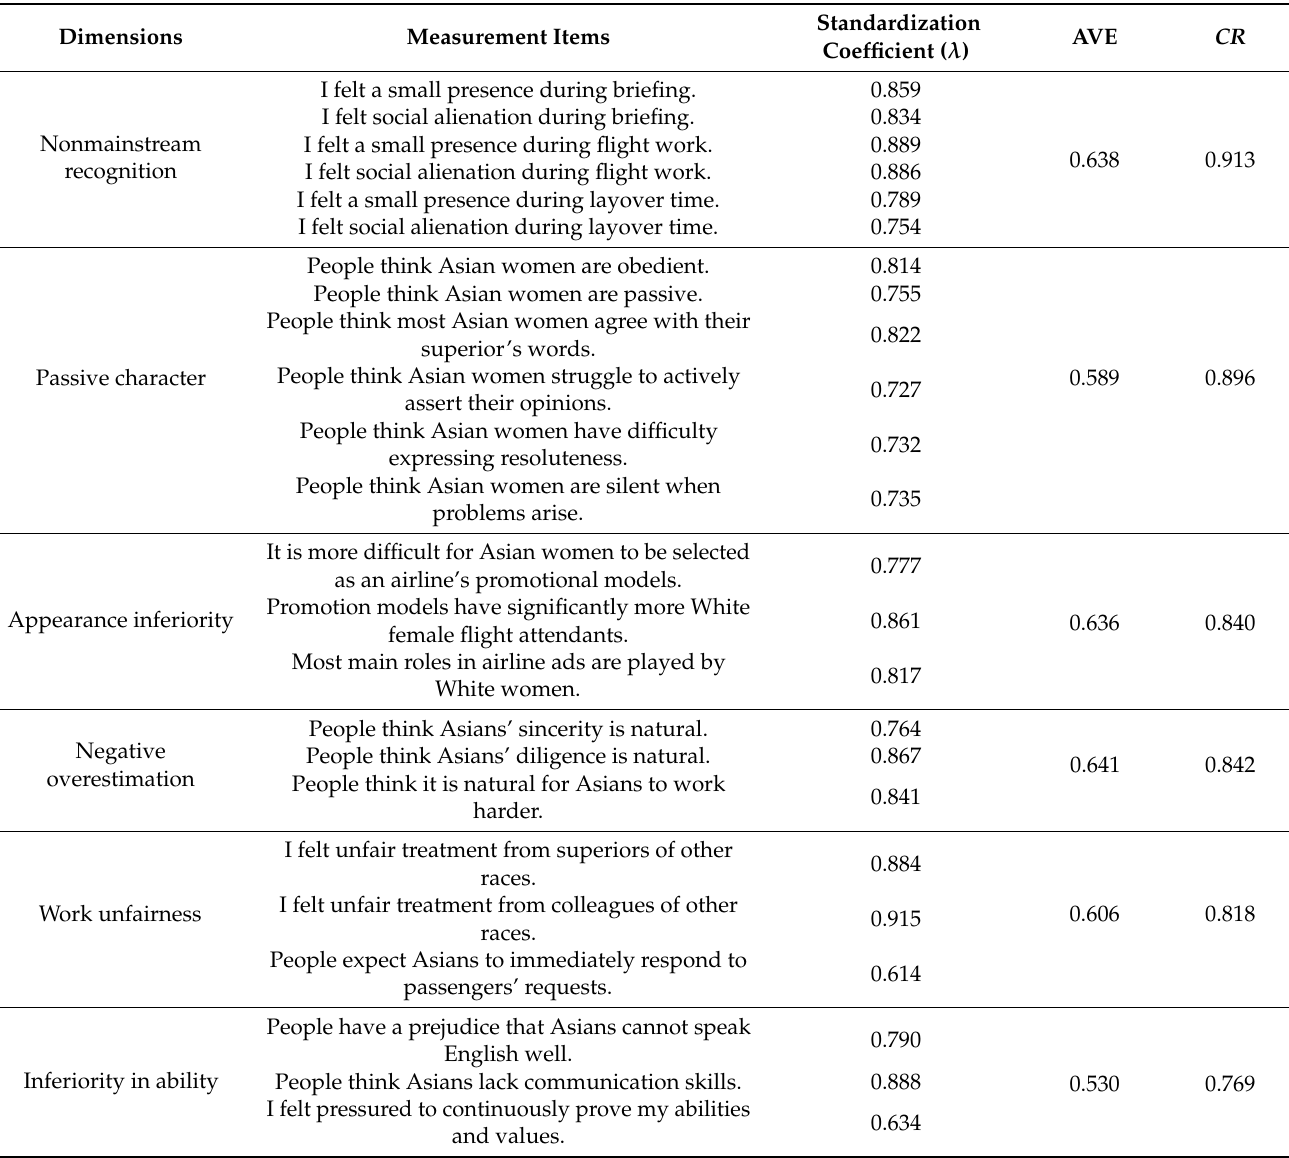
Table 6. Confirmative factor analysis